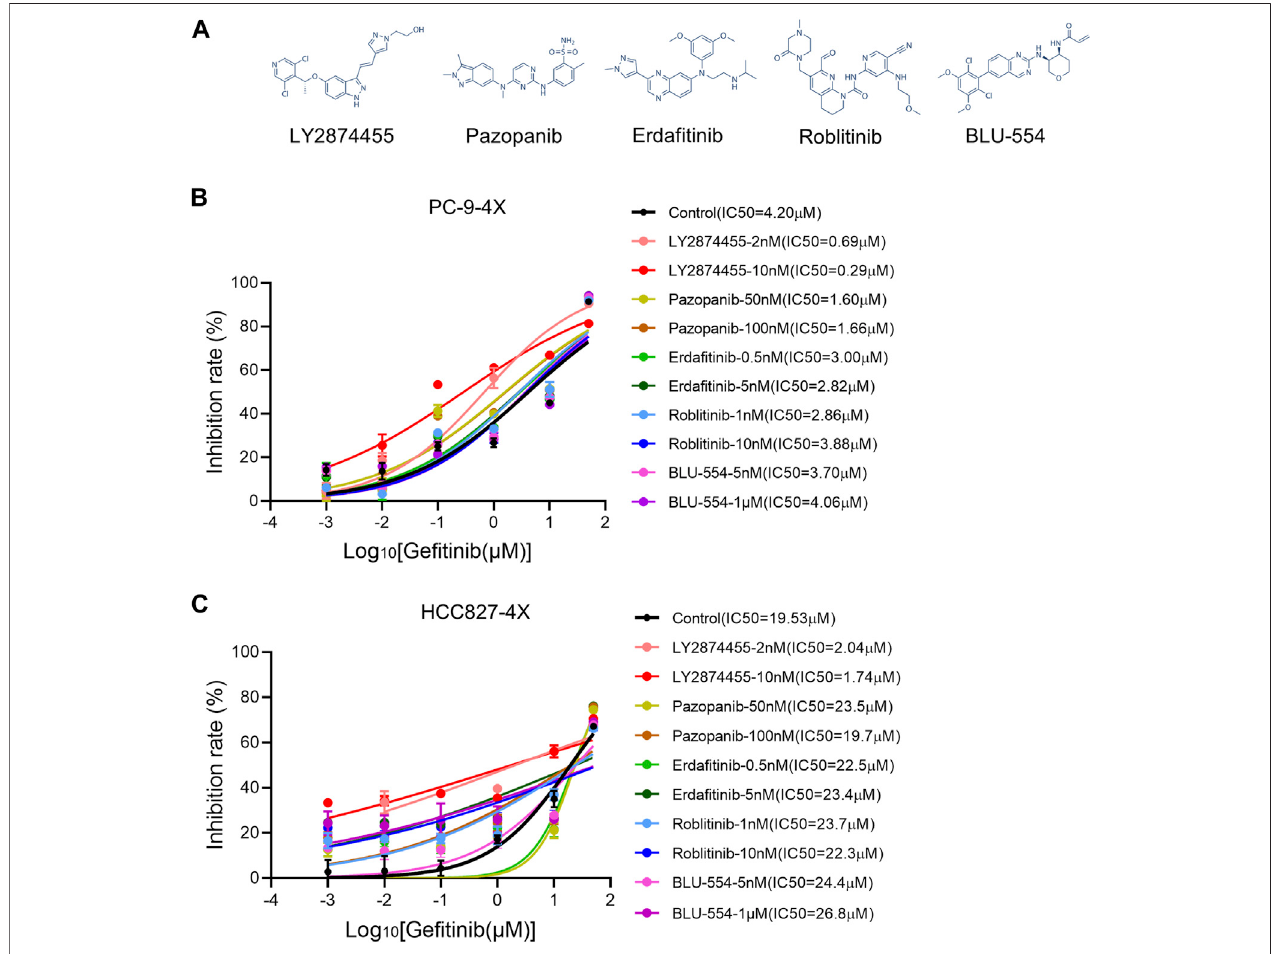
FIGURE2| ScreeningofFGFR inhibitors forovercoming ge fi tinibresistanceinducedbyFGFs/CCND1. (A) Thestructural formulaeofFGFR inhibitors. (B,C) PC-9- 4X and HCC827-4X cells were treated with ge fi tinib combined with each FGFR inhibitor for 72 h. The inhibition rate was detected by the CCK8 assay. Error bars indicate